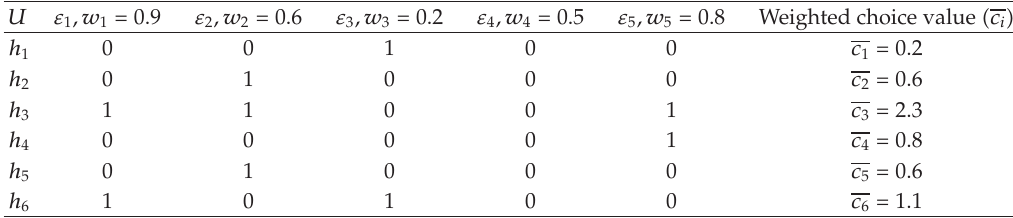
Table 11: Tabular representation of L (cid:5)(cid:5) F ,A (cid:6) ; α (cid:6) ,λ (cid:6) (cid:6) with weighted choice